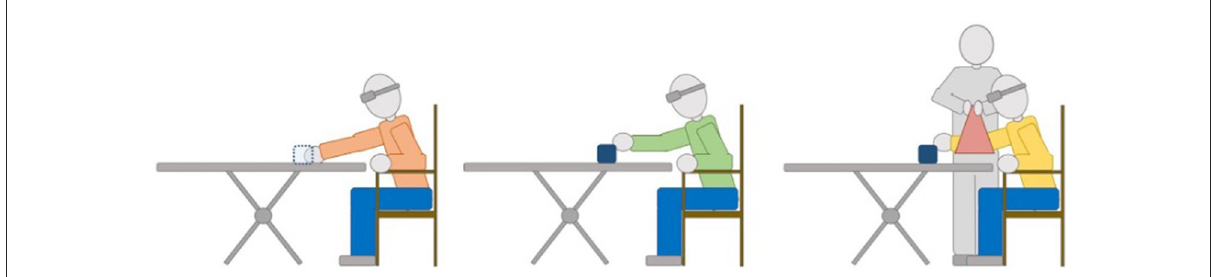
FIGURE1 Illustration of the procedure used by Hug et al. Blindfolded participants reached for a nearby sound source. They were divided into three groups that were differentiated by the intermediate training phase: control (left) , active (middle) , and guided (right)